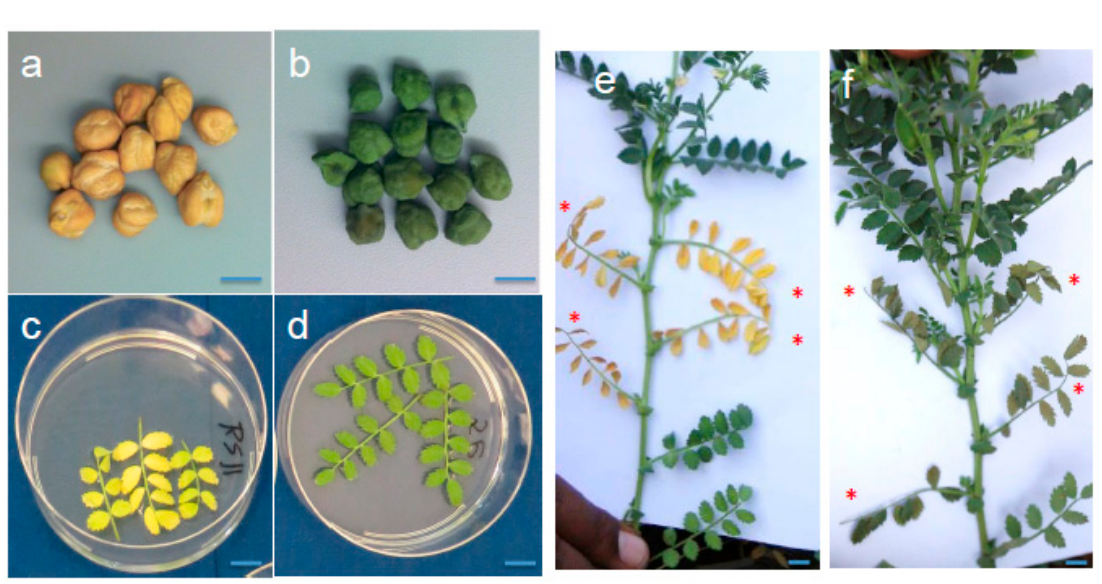
Figure 1. Seed and leaf senescence phenotypes of normal and green chickpea. Dried mature seed of common chickpea with yellow cotyledons ( a ) and of the green cotyledon colored type ( b ). Differential degreening rates in detached leaves floated on water after 5 days in the absence of light from normal chickpea ( c ) and green cotyledon type ( d ), and from leaves wrapped in aluminum foil from yellow ( e ) and green chickpea ( f ). Asterisk in ( e ) and ( f ) mark leaves covered by foil for 5 days. Blue lines in each panel correspond to 1 cm.